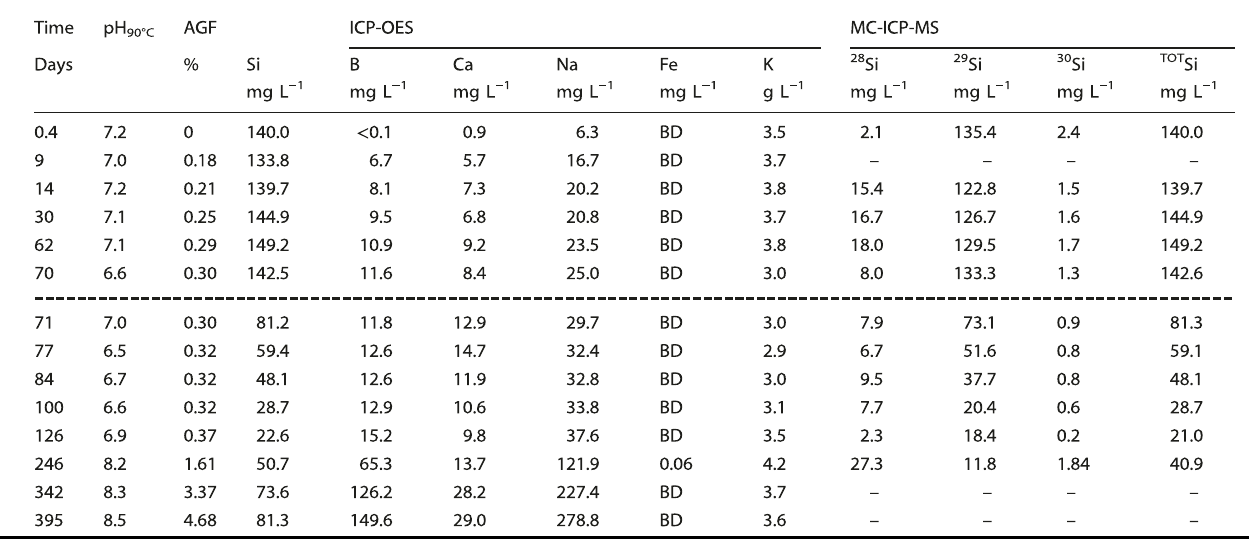
BD indicates that the value for that element was below the 0.1 mg L − 1 detection limit. Dotted line represents the addition of magnetite ‘ AGF ’ stands for altered glass fraction and ‘ - ’ within the MC-ICP-MS data denotes that the sample was not analyzed at that time point. There is a 10% uncertainty on each element measured by ICP-OES except Na which has a 50% error due to contamination within the K salts used to synthesize the potassium silicates during alkaline fusion. These potassium silicates were used to prepare the initial solution of 150 p.p.m. Si. Elements measured by MC-ICP-MS have a 5% error due to matrix effects. The dotted horizontal line represents the addition of magnetite.